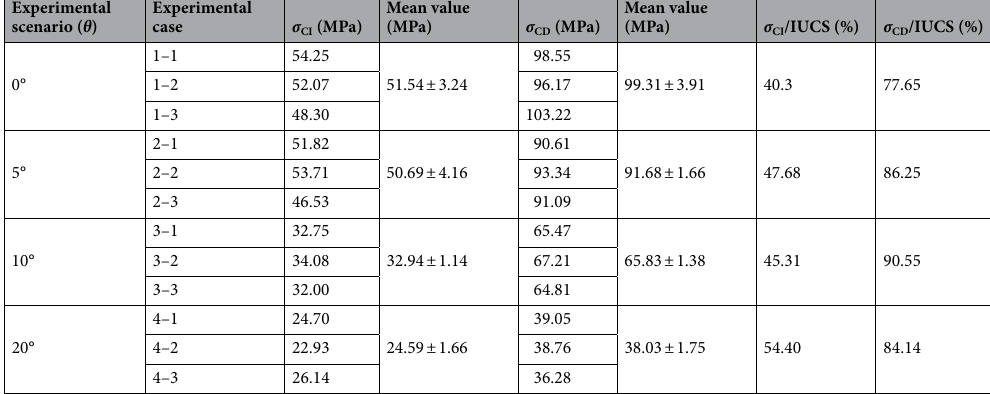
Experimental scenario ( θ )